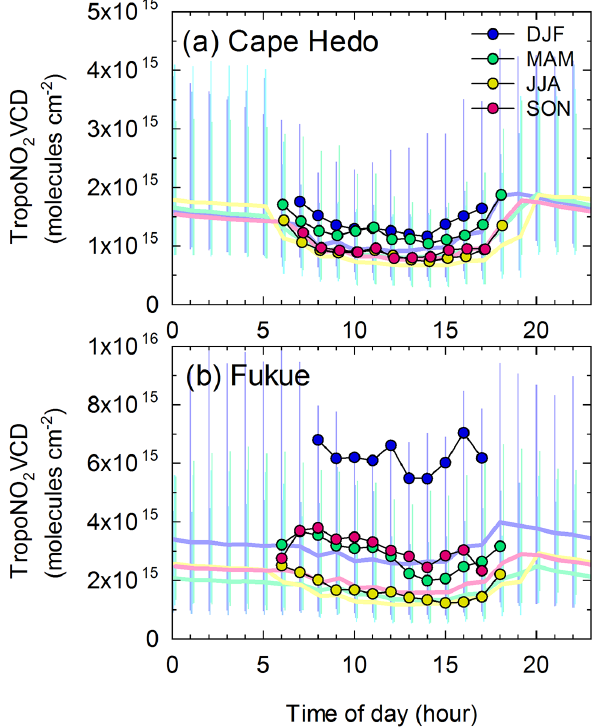
Figure 18. Comparisons of average diurnal variations in Tro- poNO2VCD derived from MAX-DOAS observations (colored cir- cles) and MIROC-ESM-CHEM model simulations (pale colored lines) for 4 seasons. Error bars for model simulations represent full ranges of hourly averages included in each